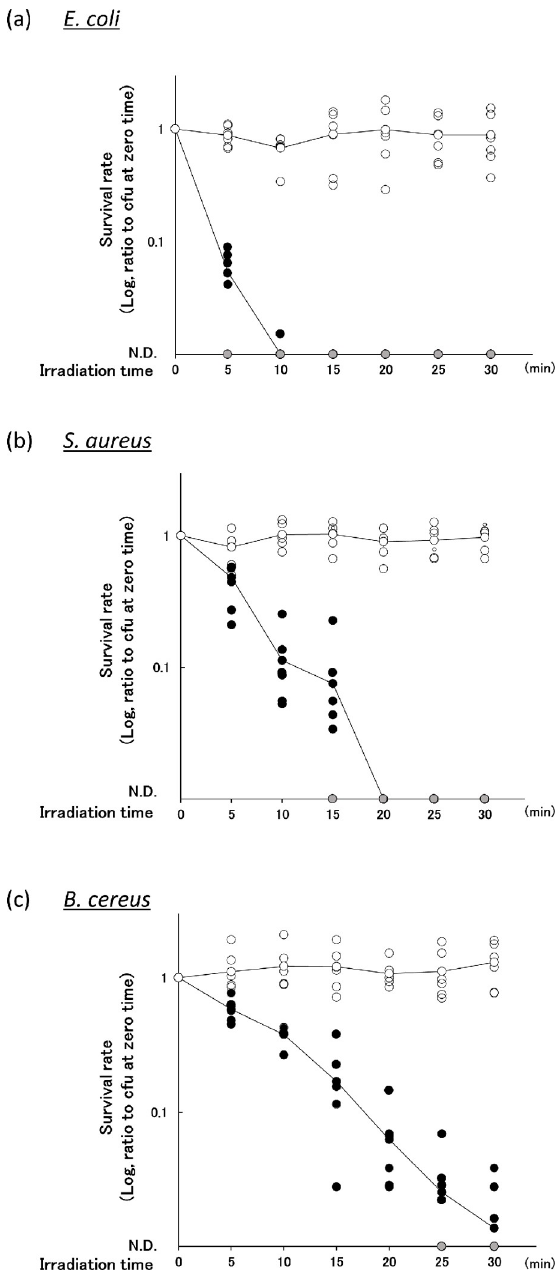
Fig 2. UV-LED inactivation of bacteria in the plasma-PC milieu. PC samples (2.75 mL) inoculated with 6 × 10 3 – 2 × 10 4 cfu of (a) E . coli , (b) S . aureus , and (c) B . cereus were irradiated with UV-LED at 265 nm up to 30 min. Samples (100 μ L) were taken every 5 min and incubated overnight for colony count determination. Mean cfu of (a) E . coli , (b) S . aureus , and (c) B . cereus from 100- μ L PC samples before irradiation were 50.8, 28.5, and 38.8, respectively. The survival rate was determined as the cfu at each sampling time relative to the cfu before irradiation. The control samples (without UV-LED irradiation) and UV-LED-irradiated samples are displayed as open and closed circles, respectively. The mean value of six independent experiments is shown as a solid line. Those not-detected (ND) are shown as grey circles, and the limits of detection for (a) E . coli , (b) S . aureus , and (c) B . cereus were 0.017, 0.014, and 0.016, respectively. Based on the mean value of 58.6 (cm -1 ) as the 265 nm absorbance for the PC samples tested (n = 520), the average irradiance (adjusted using the Beer-Lambert law) was 0.0156 mW/cm 2 . Thus, on average, irradiation times of 5, 10, 15, 20, 25, and 30 min correspond to fluence values of 4.6, 9.2, 13.9, 18.6, 23.5, and 28.5 mJ/cm 2 , respectively.